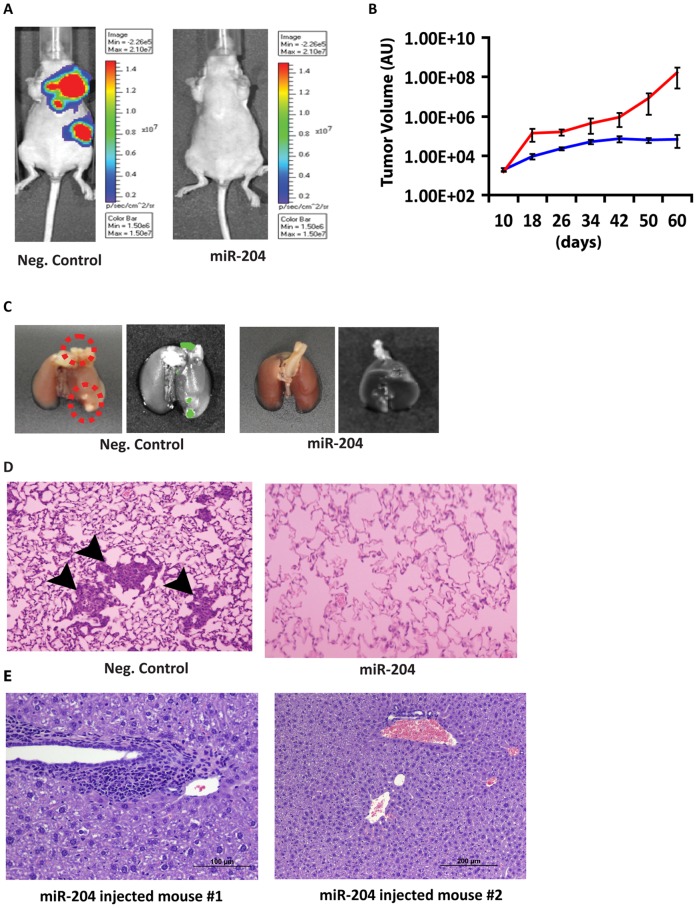
Systemic delivery of miR-204 suppresses tumor metastasis.A, injection of miR-204 oligonucleotide into tail vein suppressed lung metastasis. Live bioluminescence images of mice injected with miR-204 (n = 6) or miR-204 mutant (neg. control; n = 6) oligonucleotides using the Xenogen In Vivo Imaging System (IVIS) (Xenogen). Images were taken after subcutaneously injecting 150 mg/kg D-luciferin substrate in PBS to anesthetized mice. B, tumor metastasis volume was assessed starting from day 10 until animals were sacrificed at day 60. Using ROI analysis, tumor light intensity was calculated in photon/s, which corresponds with the number of live cells in vivo. C, representative lung images showing GFP+ve foci (red circle) in neg. control groups. D, representative lung sections showing metastatic foci in neg. control groups. E, no hepatotoxicity in miR-204 injected mice. Sections of liver from miR-204 injected mice show no signs of hepatotoxicity. The presence of multifocal periportal lymphocytes is not unusual and is a common finding in young animals.